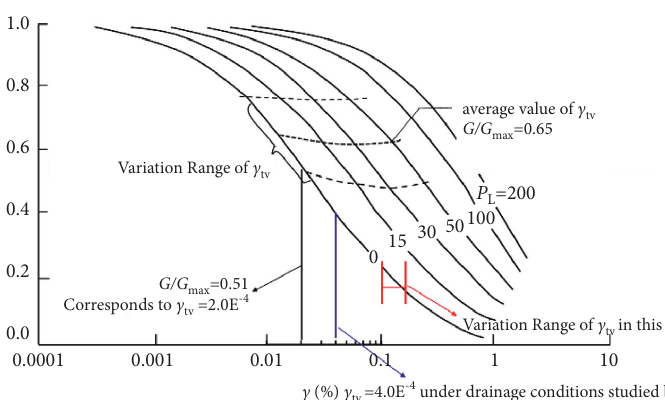
Figure 10: Critical volumetric effect strain c